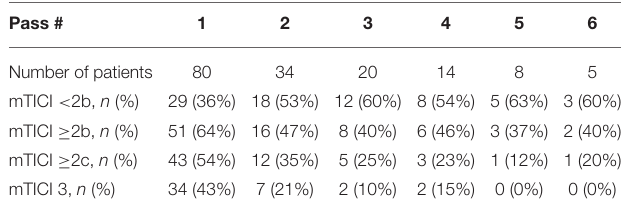
TABLE 3 | Per pass reperfusion